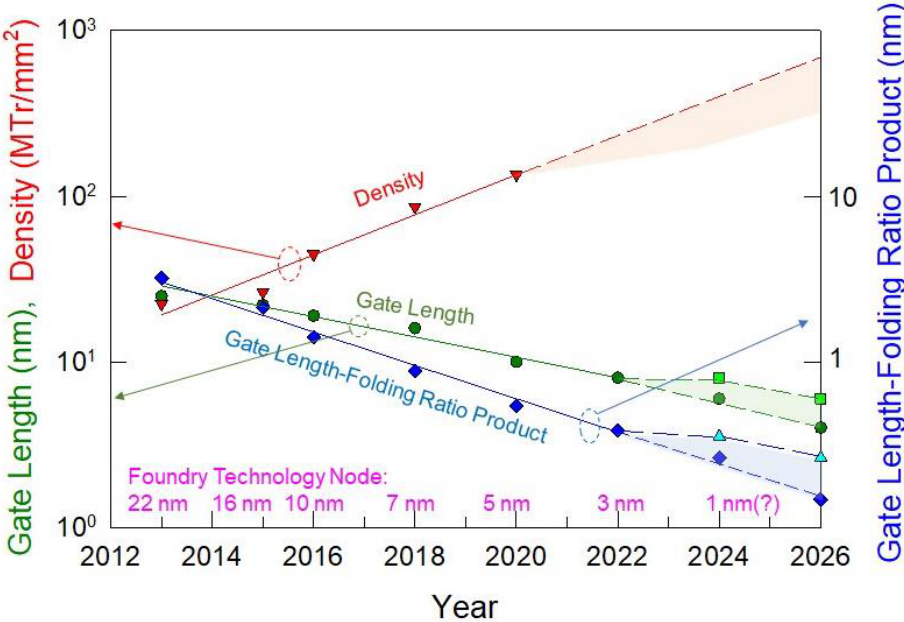
Figure 7. The upscaling of chip density still follows Moore’s law with the continued reduction in the layout size (redrawn based on [18]). The gate-length-reduction rate was slowed down. Additional footprint reduction was achieved by folding the channel width around the tri-gate FinFETs and by increasing the FinFET for 5 nm technology and beyond.